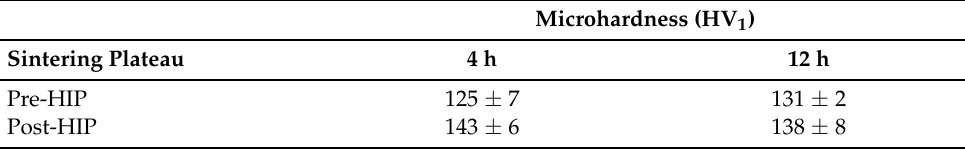
Table 1. Microhardness values in the samples subjected to the different heat